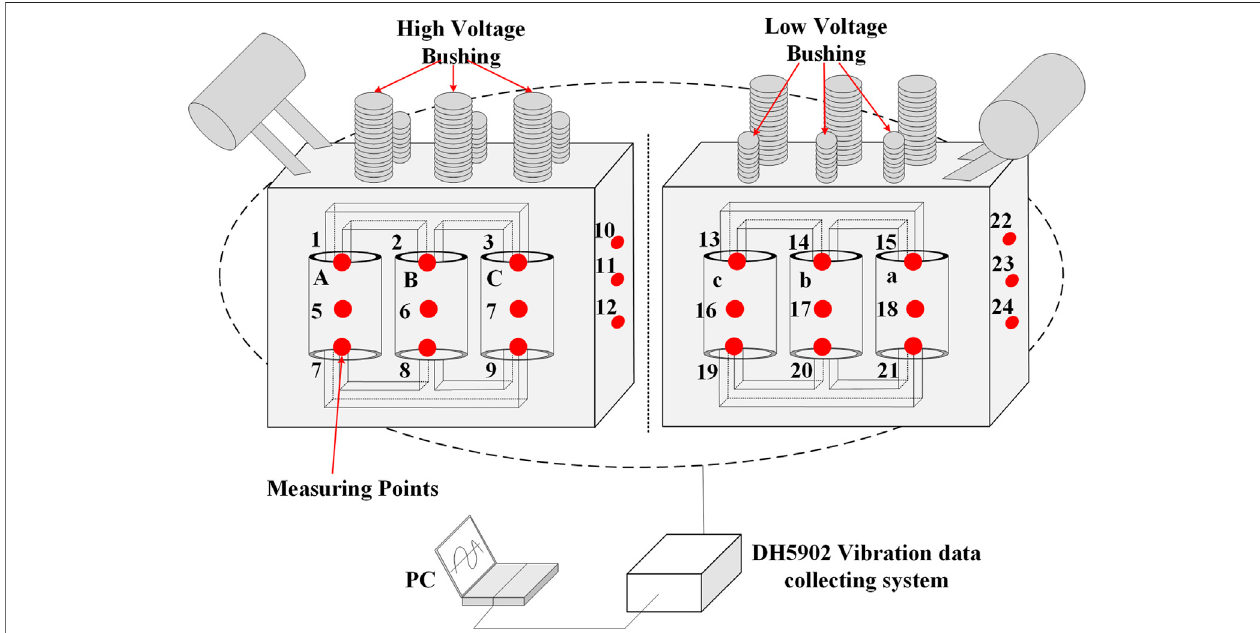
FIGURE 4 | Tank vibration signal measuring